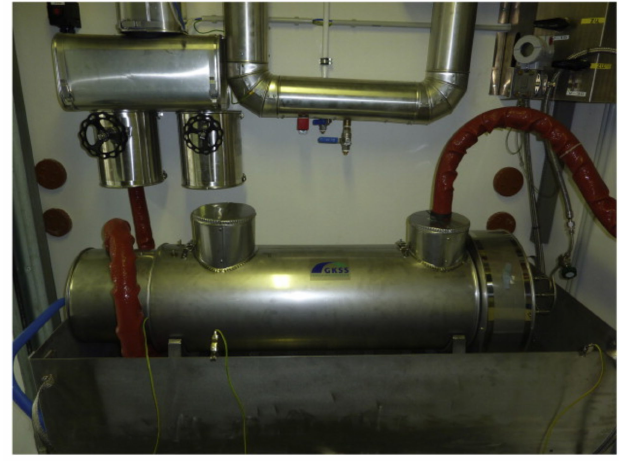
Figure 5. Prototype NaAlH 4 storage tank developed in GKSS laboratories